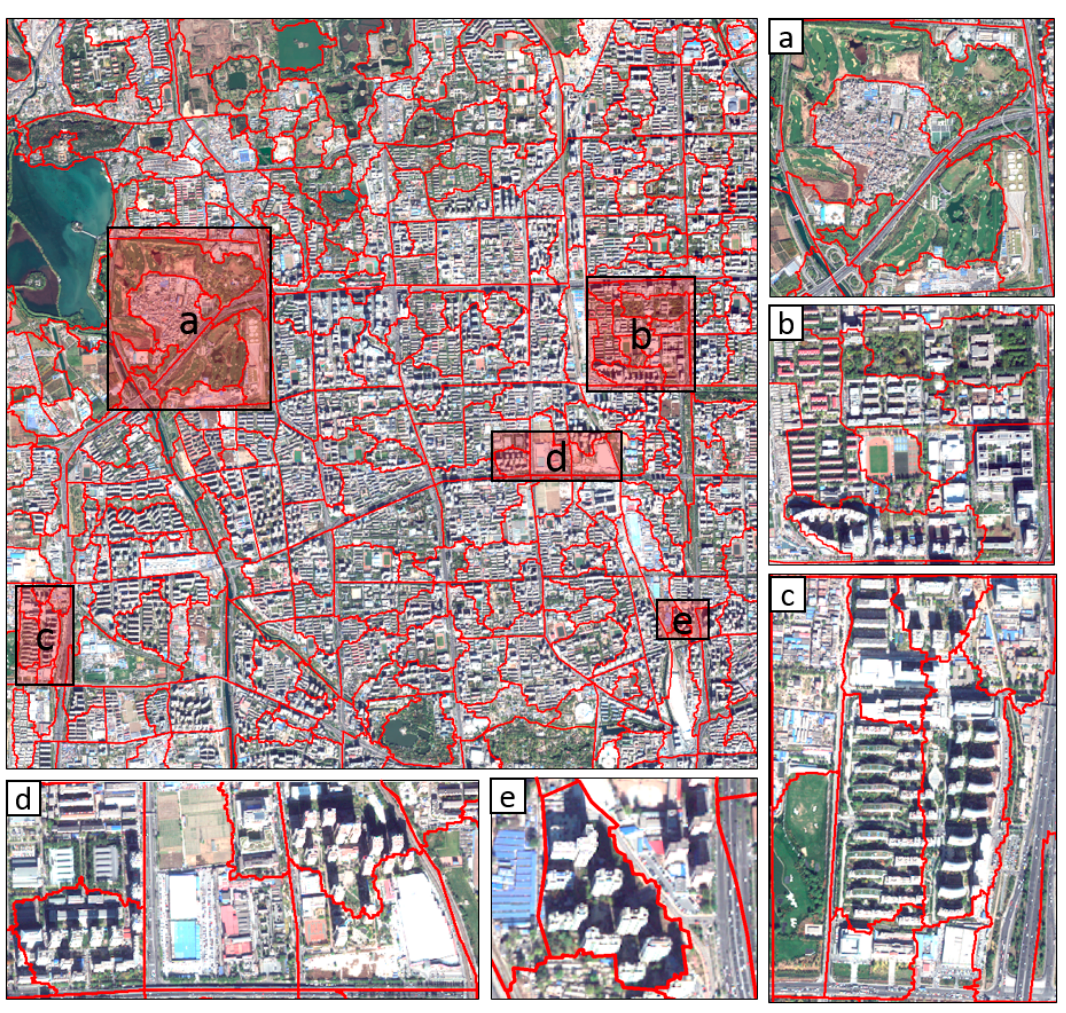
Figure 16. Geoscene segmentation results in the study area. The segmentation results of five sub-regions ( a – e ) are presented for visual interpretation.